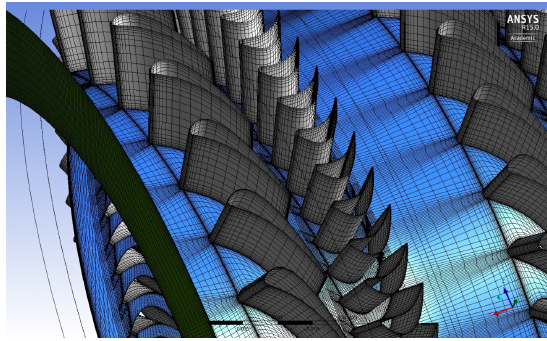
Figure 2: Mesh details at the metal surfaces of the flow channel in the ORC mini